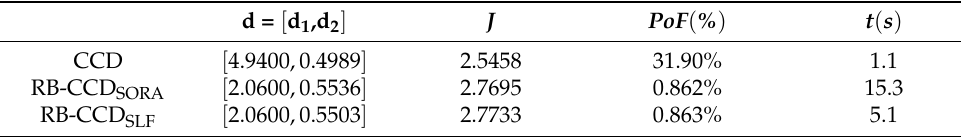
Table 1. The results of CCD and RB-CCD for Example 1.